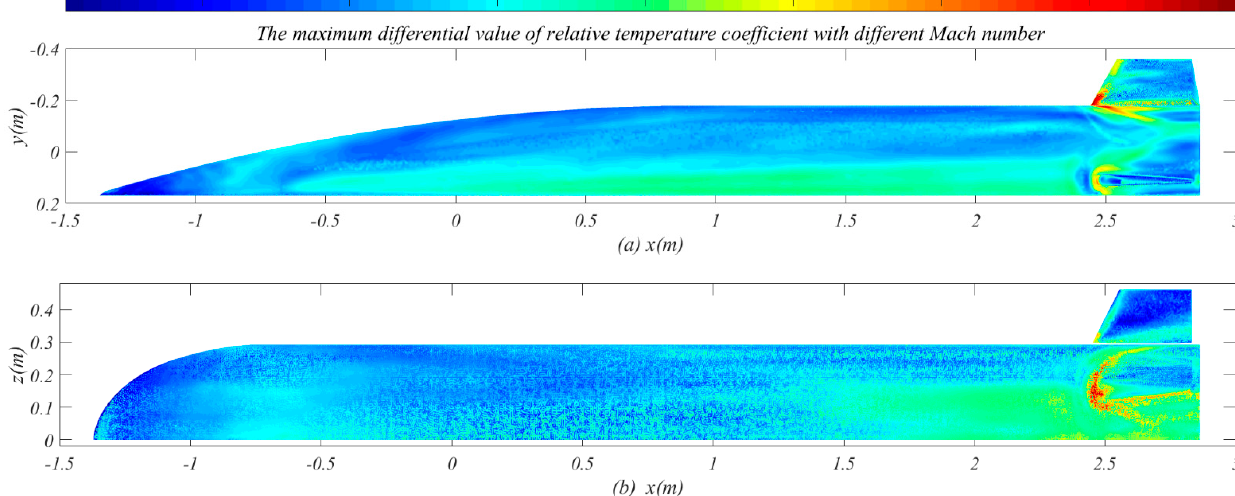
Figure 12. The maximum differential value of relative temperature coefficient with different Mach number: ( a ) the side view of aircraft; ( b ) the top view of aircraft.